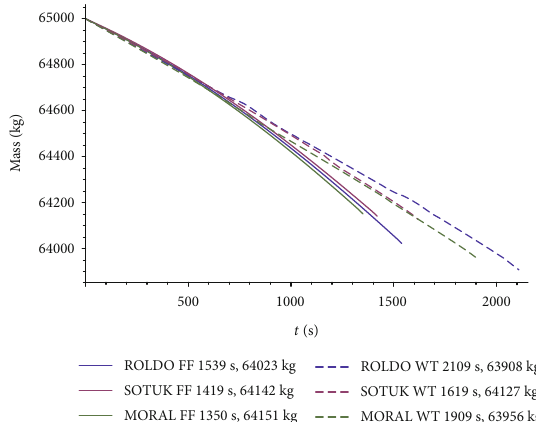
Figure 14: Experiment 3. Horizontal pro fi les with (WT, dashed lines) and without (FF, solid lines) waypoints and time-based separation